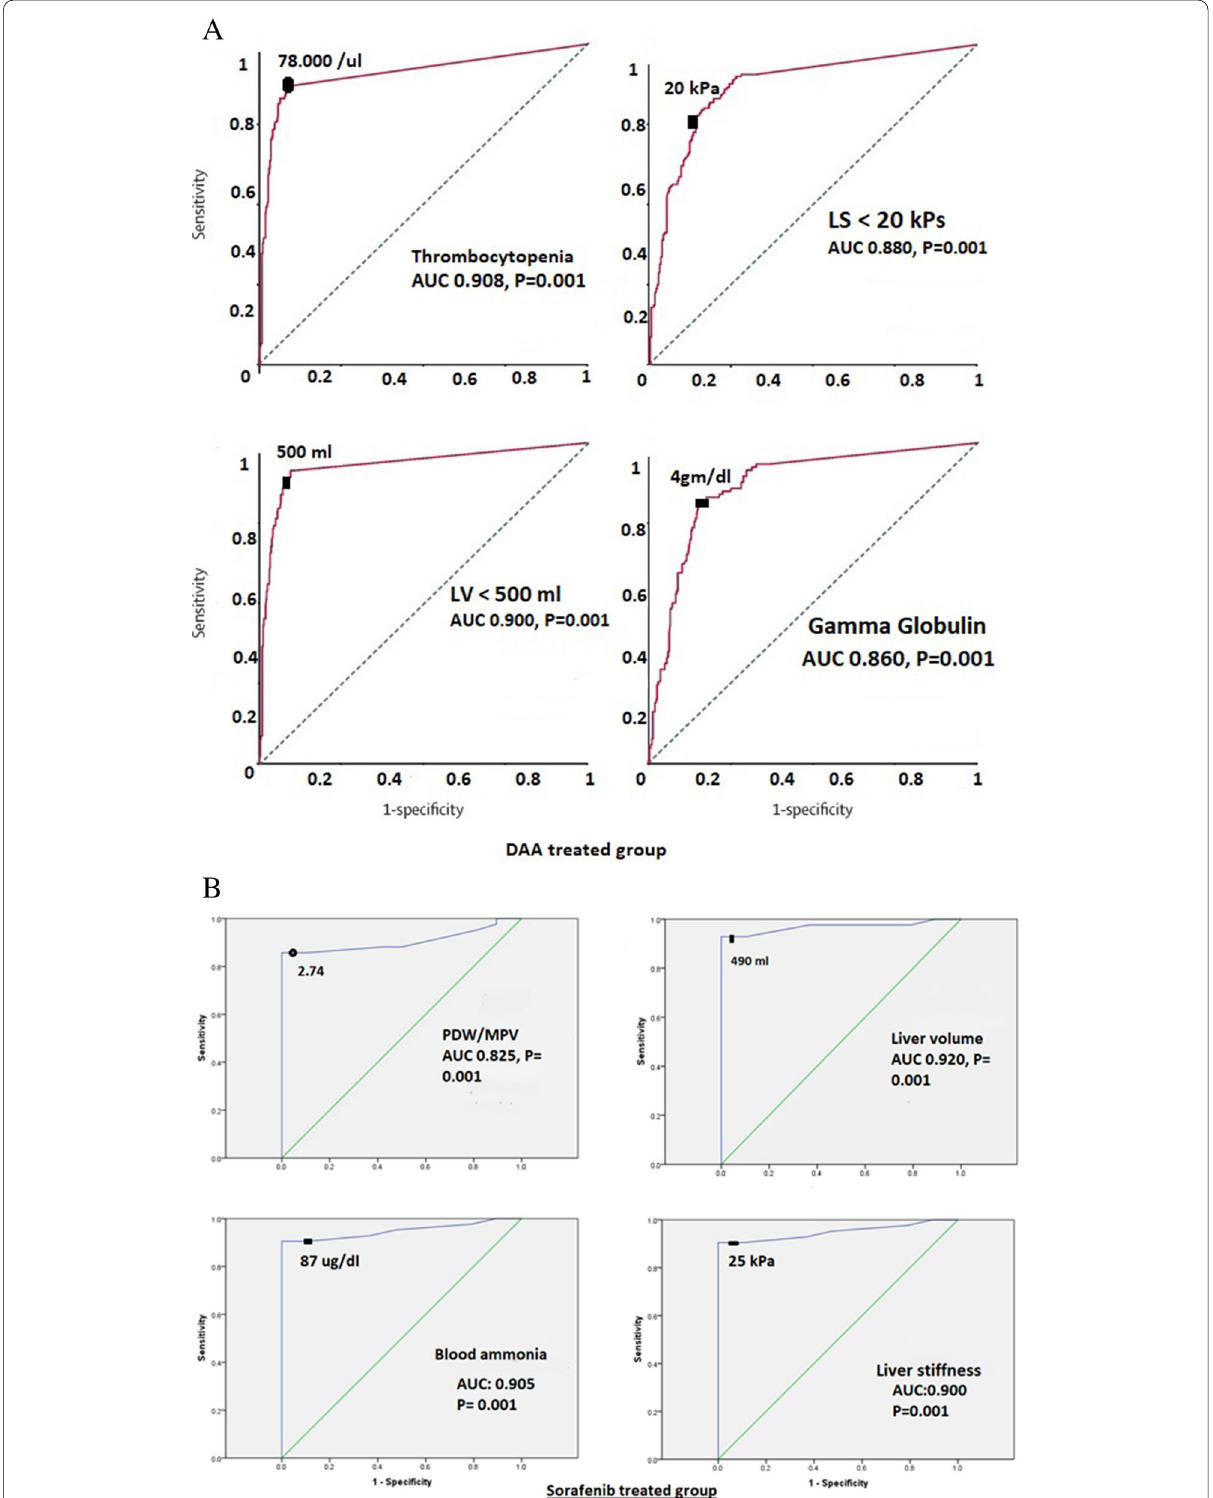
Fig. 3 a ROC curve showing the cutoff values of predictors of complications in DAAs-treated patients. b ROC curve showing the cutoff values of predictors of complications in sorafenib-treated